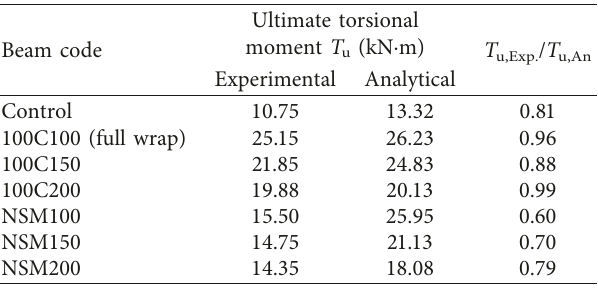
Table 7: Comparison of the experimental and analytical ultimate torsional moments. Beam